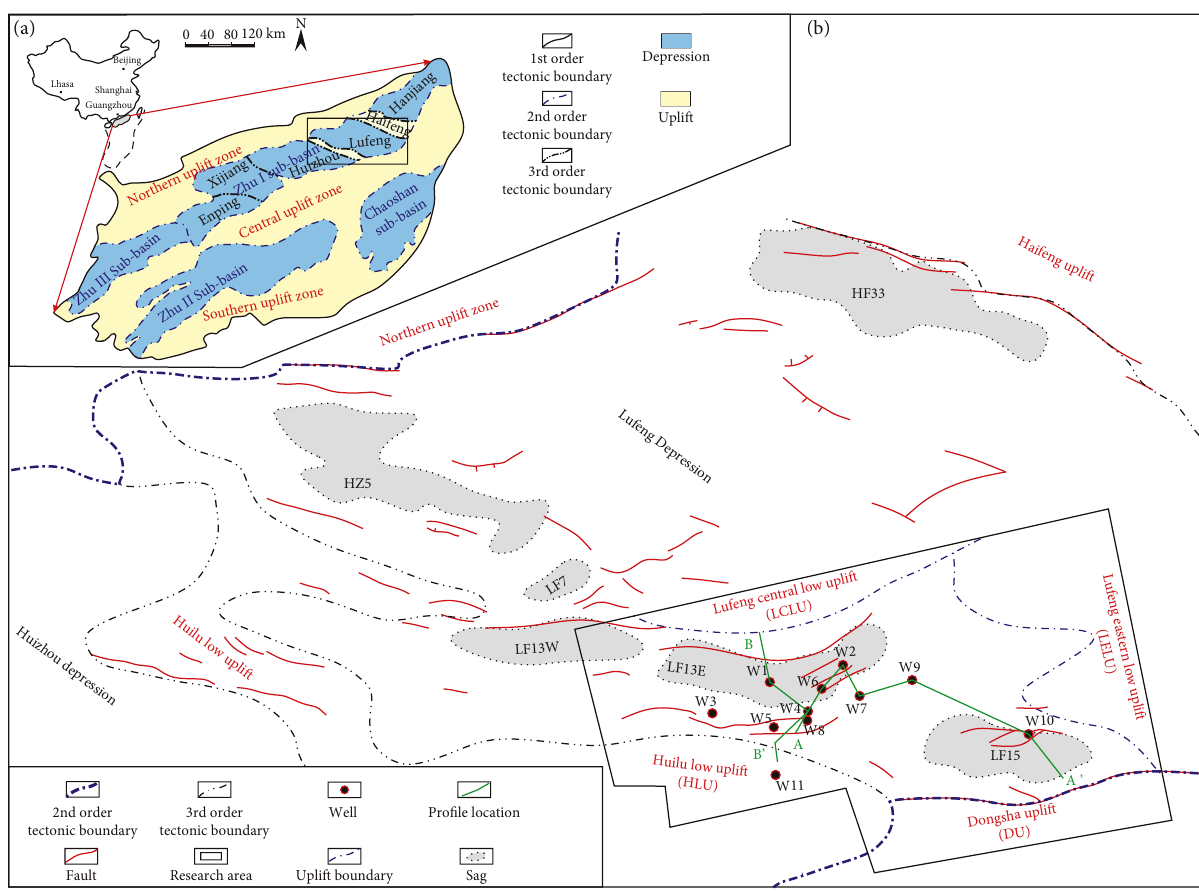
Figure 1: (a) Location of the Lufeng depression in the Pearl River Mouth Basin of China. (b) Location of the research area in the Lufeng